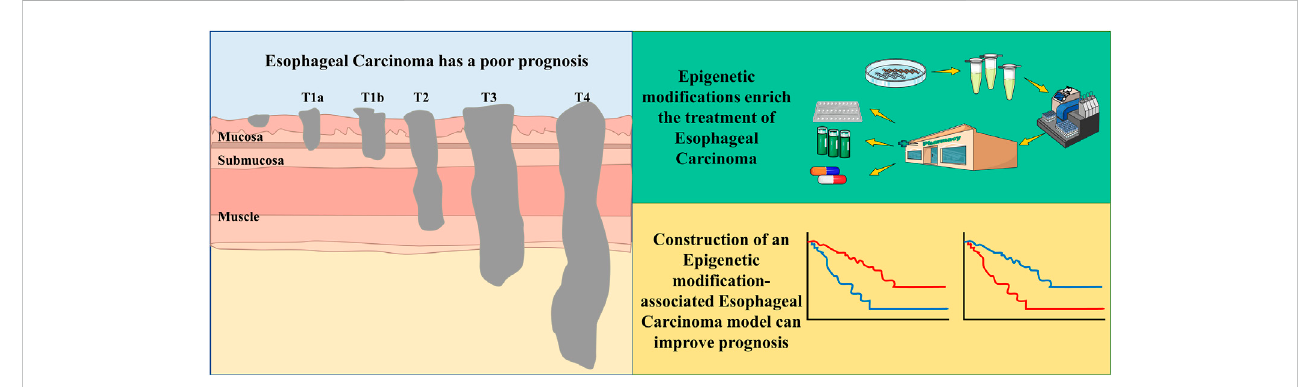
FIGURE 3 Esophageal Carcinoma being a cancer with poor prognosis, the addition of epigenetic mechanisms facilitates the early diagnosis, prognostic evaluation and therapeutic drug development aspects of the